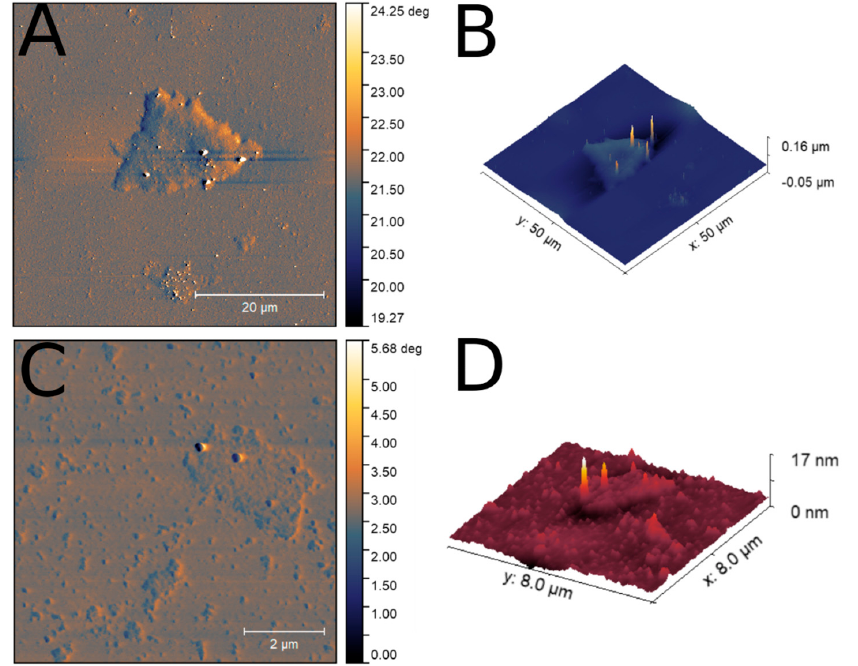
Figure 4. Atomic Force Microscopy (AFM) phase images of PVA@rGO-Ag1 ( A ) 50 × 50 µ m and ( C ) 8 × 8 µ m and ( B , D ) the related 3D Height.